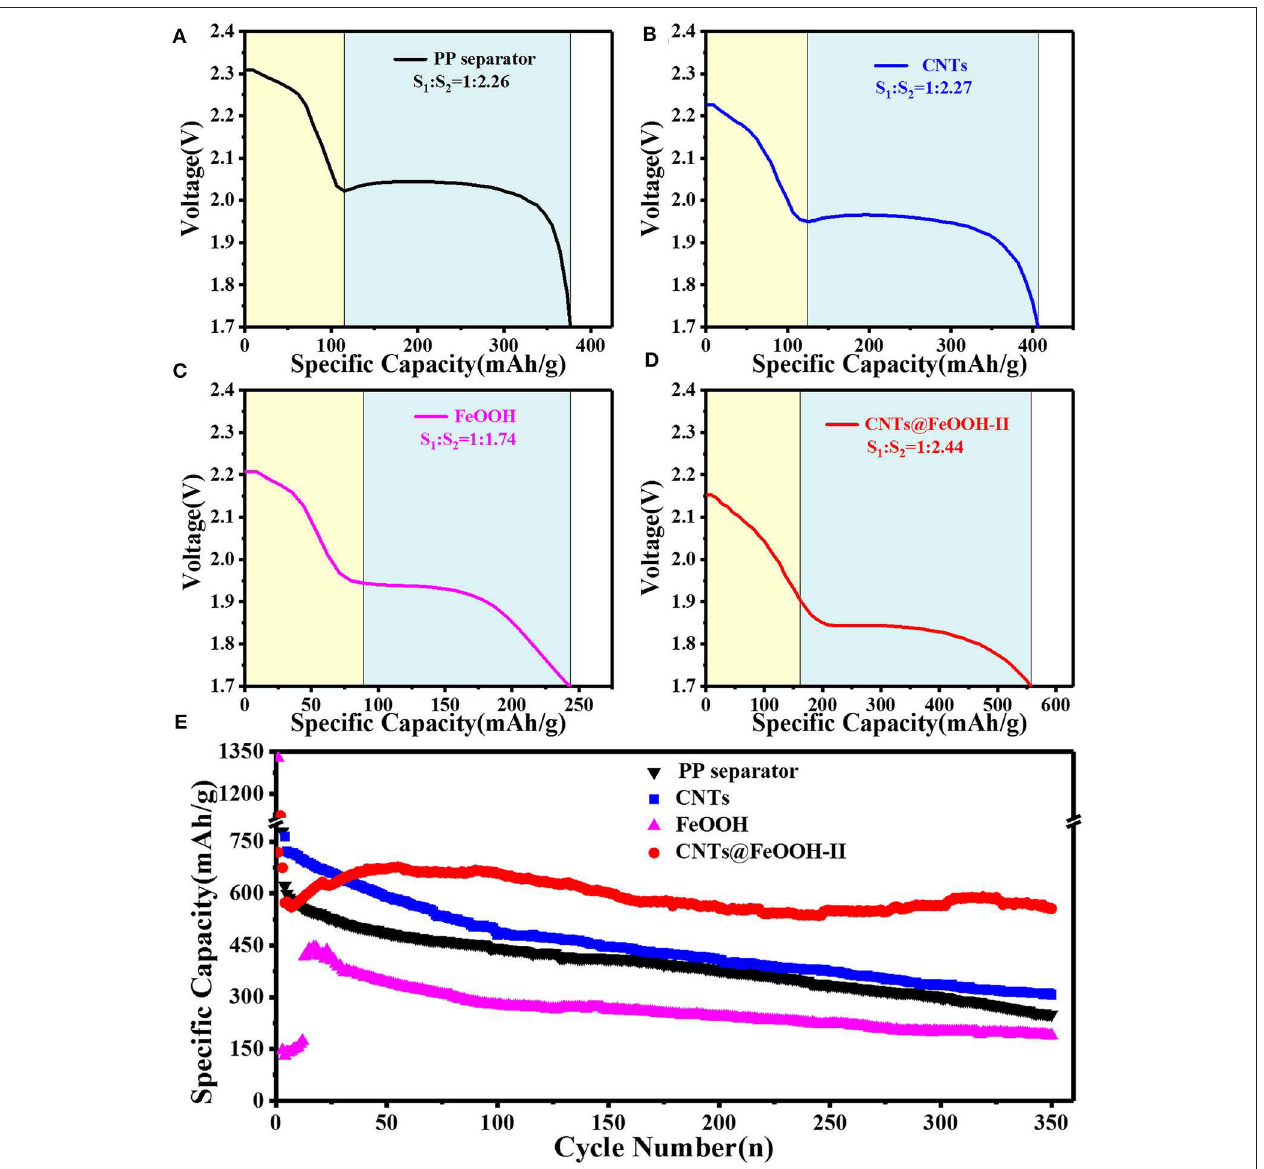
FIGURE 4 | The 200th cycle Discharge profiles of the battery with (A) PP separator, (B) CNTs, (C) FeOOH, and (D) CNTs@FeOOH-II separator, respectively, at 3,200 mAh g − 1 ; (E) cycle performance at 3,200 mAh g − 1 .